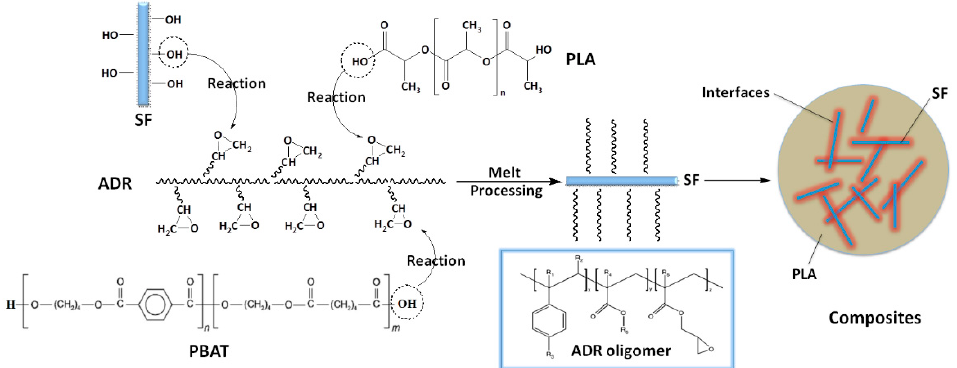
Figure 5. Illustration of interfacial compatibilization between PLA, SF, and PBAT via in-situ reaction with ADR oligomer during melt-blending processing.